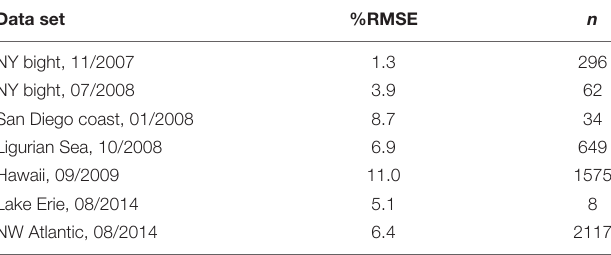
TABLE 3 | Percent (%) RMSE results after fitting two clusters to VSF data collected around the